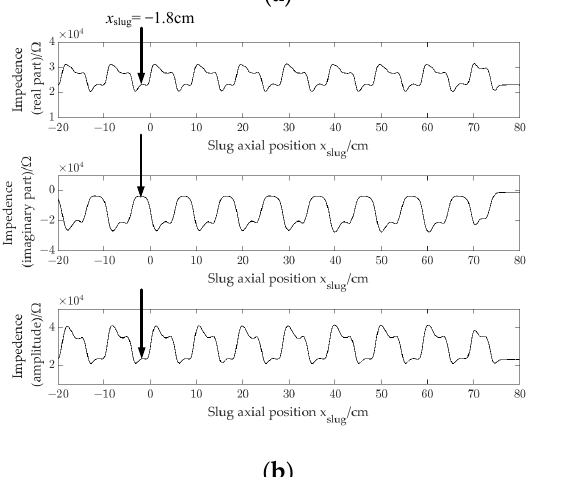
Figure 7. Photographs and impedance signals: ( a ) photographs; ( b ) impedance signals.